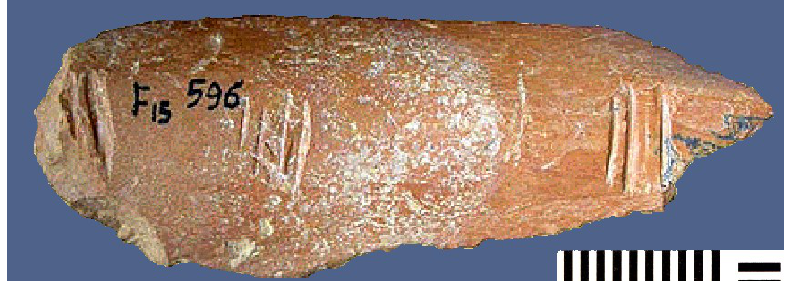
Figure 3. Bovid bone fragment bearing 10 grooves, Kozarnika Cave, Belogradchik, Vidin region, Bulgaria, from a handaxe-free tradition 1.1–1.4 million years old.